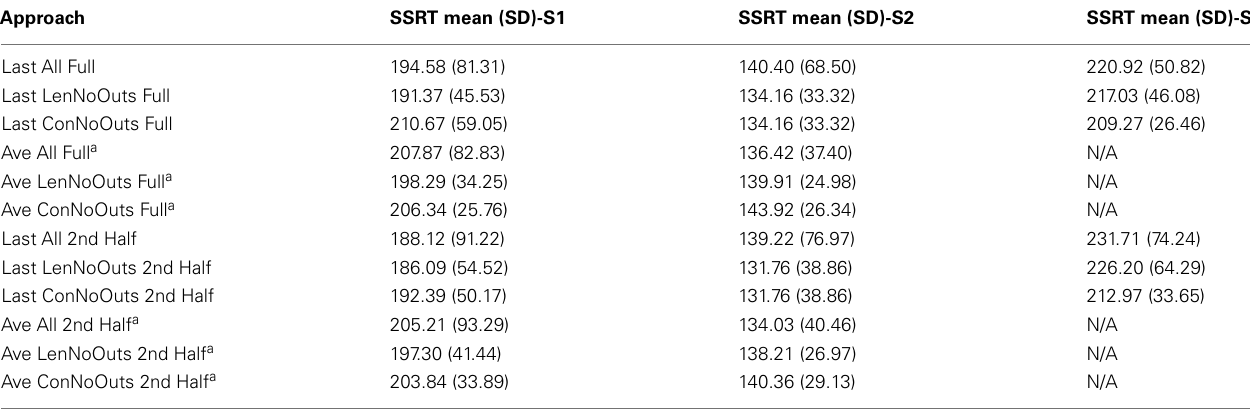
Table 3 | SSRT summaries by group and SSRT calculation